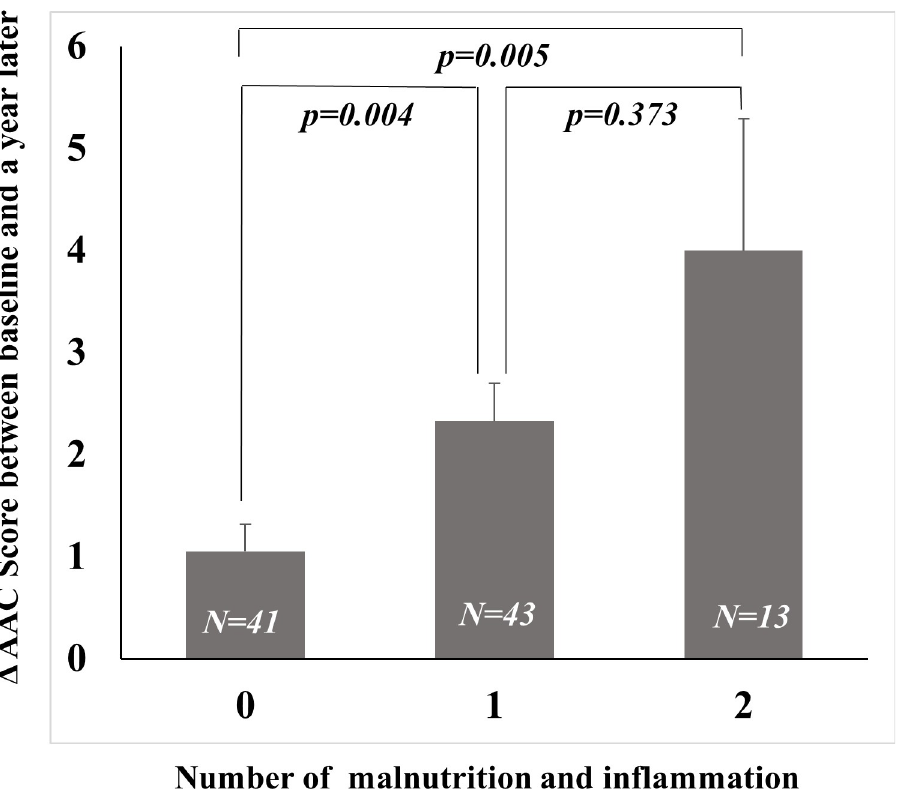
Fig 2. Changes in AAC score according to the number of malnutrition and inflammation markers. Median AAC scores increased from 1, 3, and 5 to 3, 7, and 8 in patients without any markers, with any 1 marker, and with 2 markers, respectively.